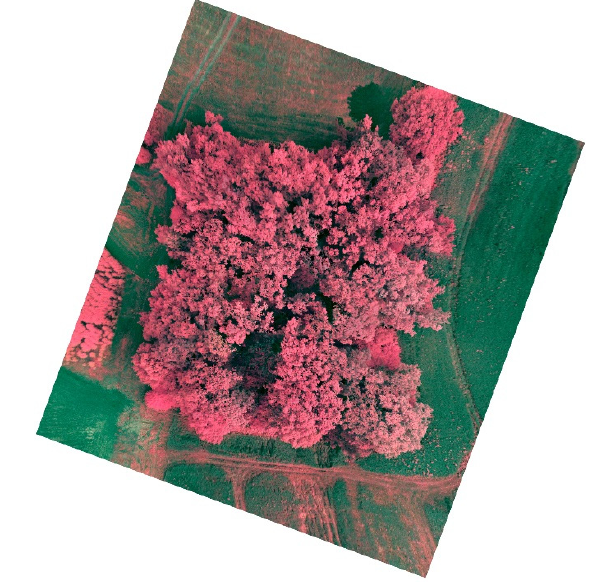
Figure 5. Resulting high-resolution colour-infrared mosaic of the study site A constructed from 44 overlapping